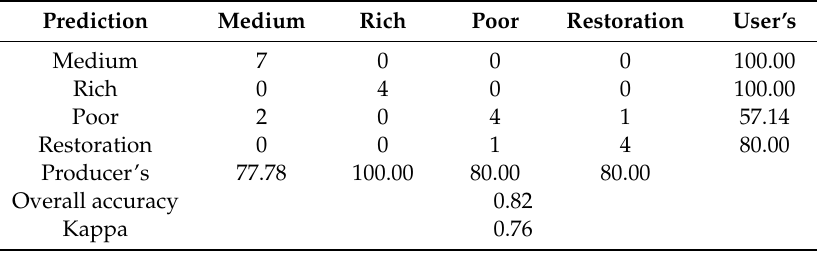
Table A5. Confusion matrix of classification in 2010.